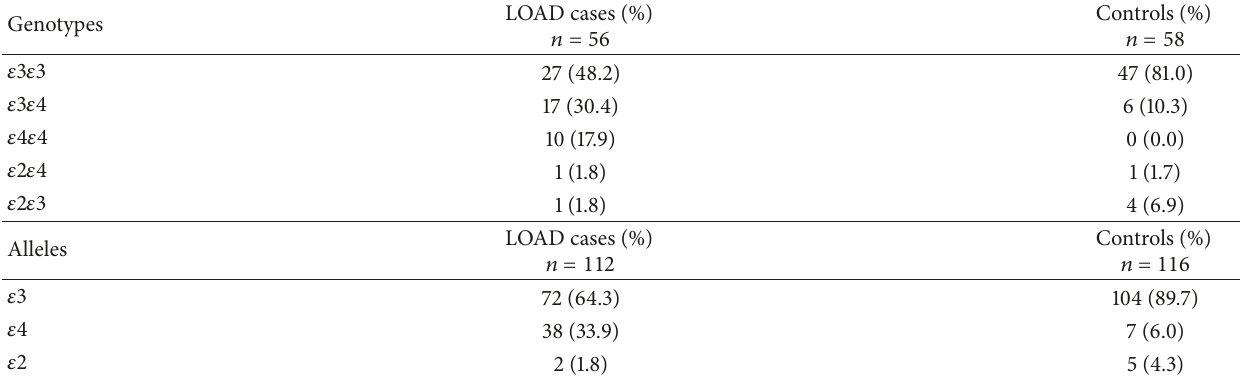
Table 2: APOE allele and genotype frequencies in case and control